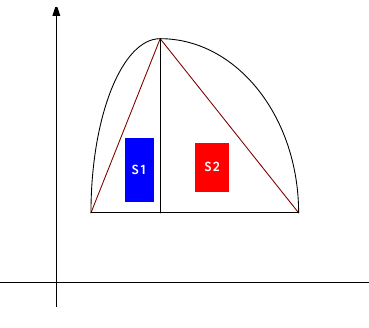
Figure 9. The definition of shape factor.